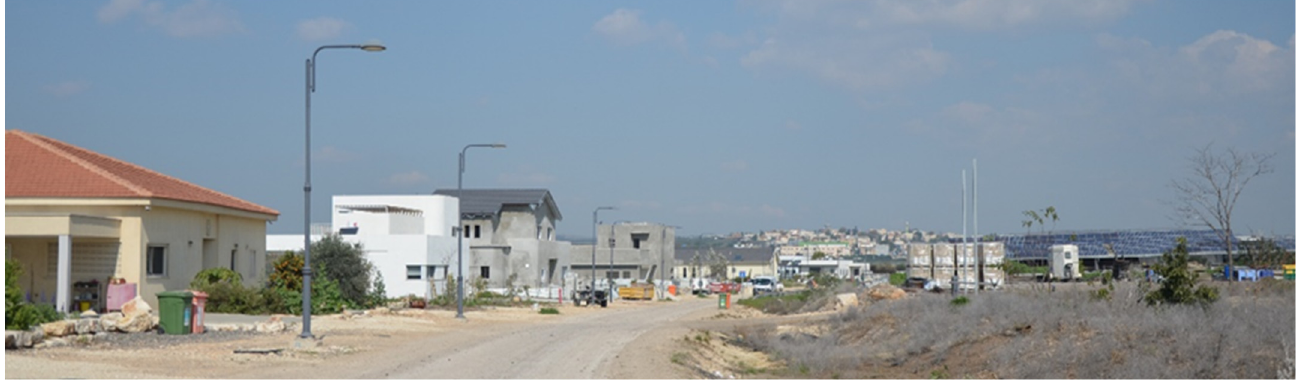
Figure 13. Houses of inheriting farmers at Nahalal’s outer perimeter, facing the farm buildings in the fi rst perimeter. Photo by the authors.